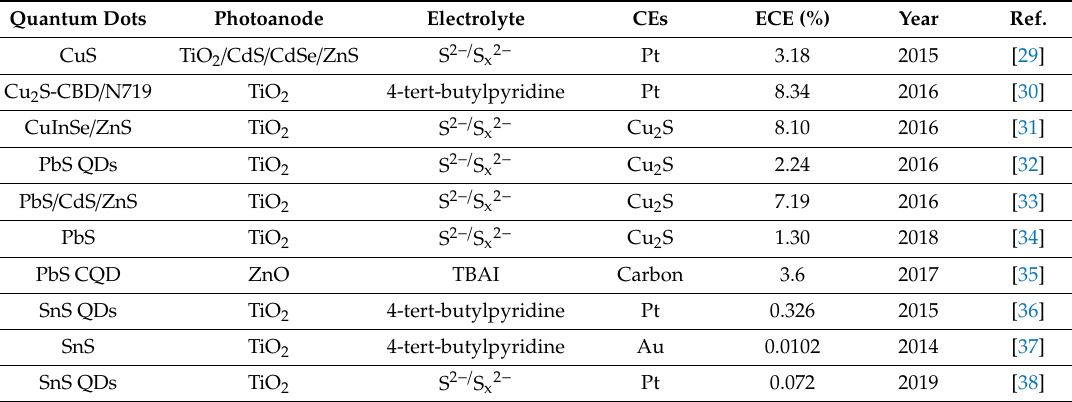
Table 1. J–V properties of PbS, CuS and SnS QDSSCs with various photoanodes and CEs. Quantum